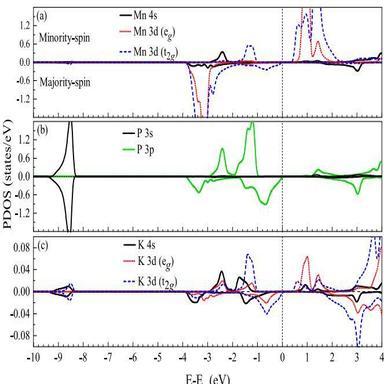
Spin-resolved site and orbital projected density of states of HH-MnPK in the bphase.